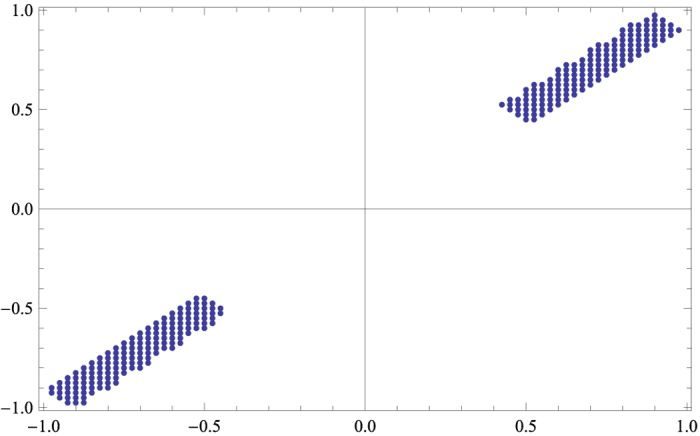
The same cross-sectional view of Fig. 2 for all p1 = 0.9, p2 = 0.9 and p3 = 0.9.